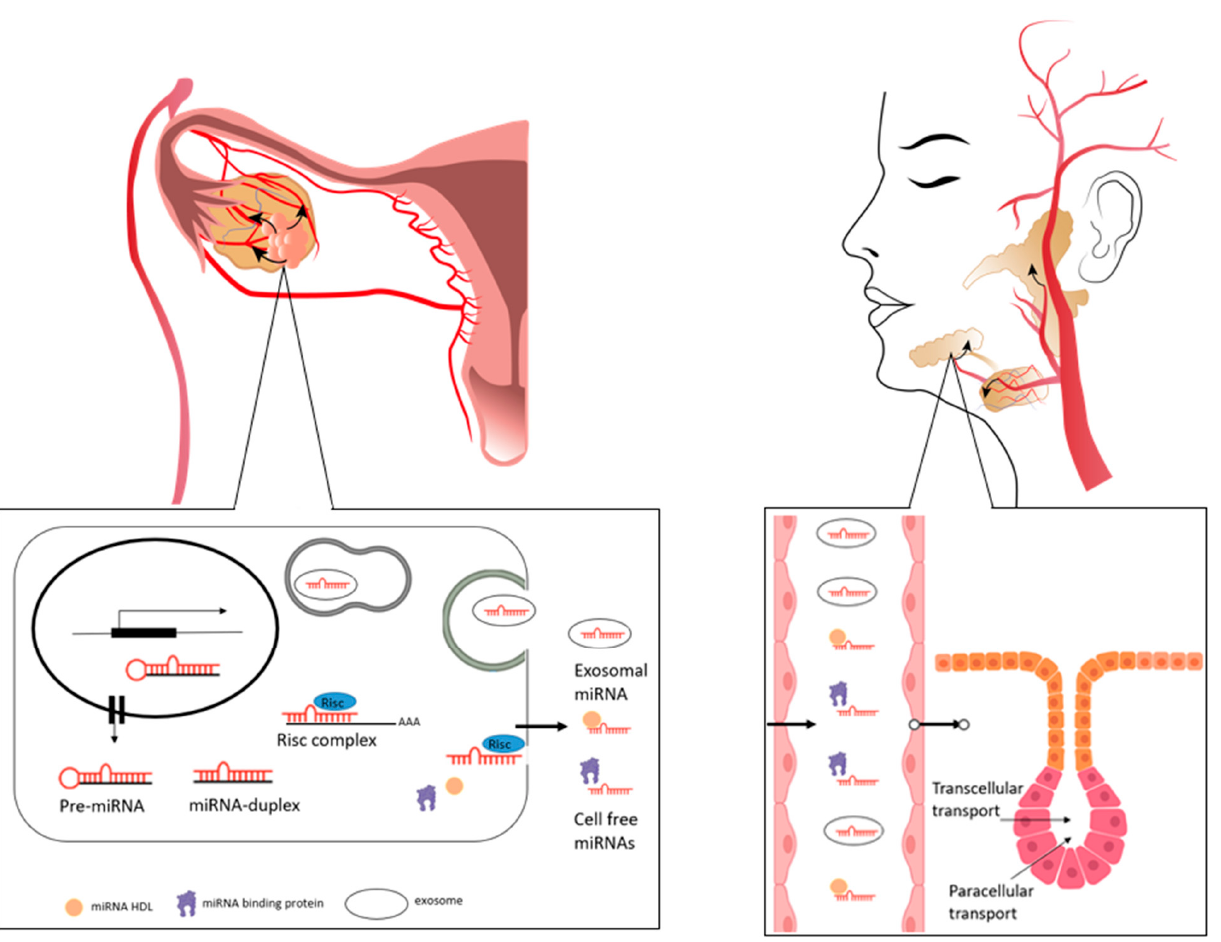
Figure 1. Anatomical and molecular visualization of miRNAs trafficking between OC tissue to bloodstream and saliva. Direction of molecular trafficking between ovarian tissue and bloodstream ( upper left ), and between blood and salivary glands ( upper right ) is indicated by arrows. There is an intense exchange of molecules from the bloodstream to the ovary and vice versa: the ovary is highly vascularized so that it is supplied with hormones and nutrients needed for its high metabolism. At the same time, small molecules, such as microRNAs, are released from the tissue, also under tumor conditions. The composition of blood therefore influences salivary composition. The salivary fluid is produced by the local vascular bed in the acinar region and through the duct system released into the oral cavity. At cell level ( lower left ), miRNAs generated in the cell are released within exosomes or associated with miRNA binding proteins (such AGO2) or high-density lipoprotein (HDL). They are stable and protected by RNase degradation. Intra- and extracellular mechanisms allow these molecules to be transported from blood to saliva ( lower right ), so they can be found in the oral cavity reflecting a distant physiological or pathological